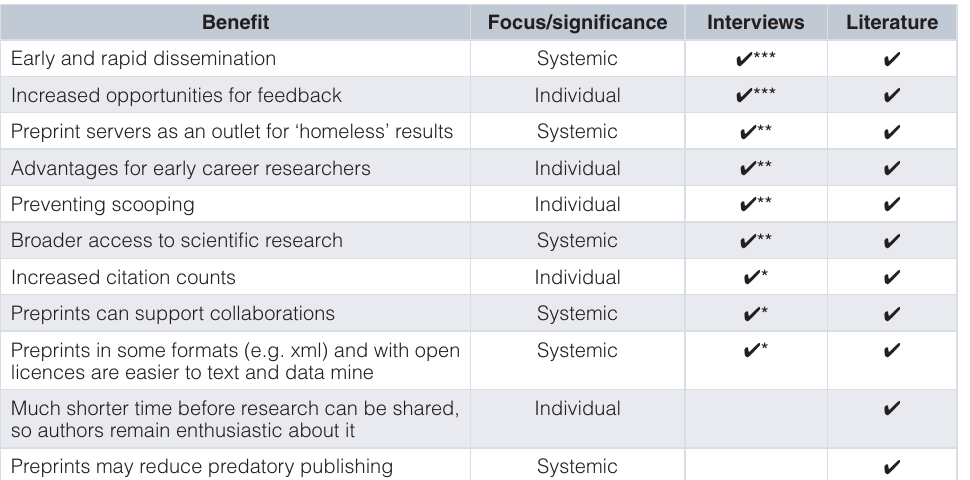
Table 5. Potential benefits of preprints. Mentions across the entire dataset: ✔ *** =over 20 mentions; ✔ ** =between 10 and 20 mentions; ✔ * =fewer than 10 mentions. “Systemic” significance relates to those factors with system-wide impact e.g. the broad scholarly communication system or disciplinary community; “individual” relates to those factors primarily affecting individuals or small